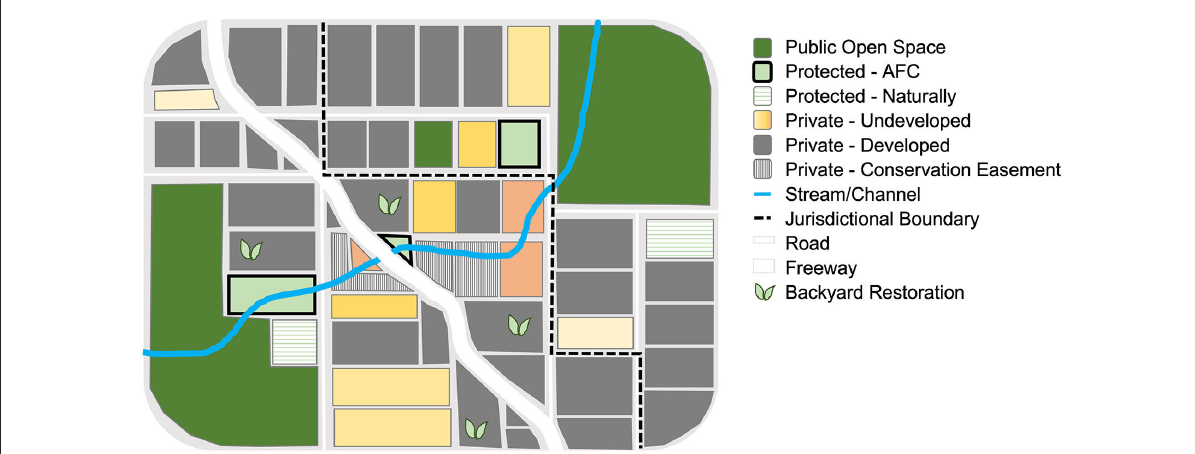
FIGURE1 Illustration of the complexity of conserving urban wildlife corridors. Land parcels are shown on a street map with roads (white lines), jurisdictional boundaries (black dashed lines) and an urban stream channel (blue line). The culvert under the freeway (thick white line) would be assessed as a potential wildlife passage corridor. Land parcels are colored based on their ownership and status. Preserved public open space includes parks and undeveloped natural habitat (green). Privately owned undeveloped parcels are split into parcels that have been acquired and therefore protected (light green, black border), parcels that have been protected naturally due to land ordinances (green horizontal stripes), and parcels that have been ranked for corridor conservation need ranging from high (orange) to low (light yellow). Parcels in orange would be ground-truthed to assess conservation potential. Privately owned occupied parcels include developed parcels (grey) and parcels with conservation easements (grey vertical stripes). Properties on which landowners have participated in backyard restoration projects are also indicated (green